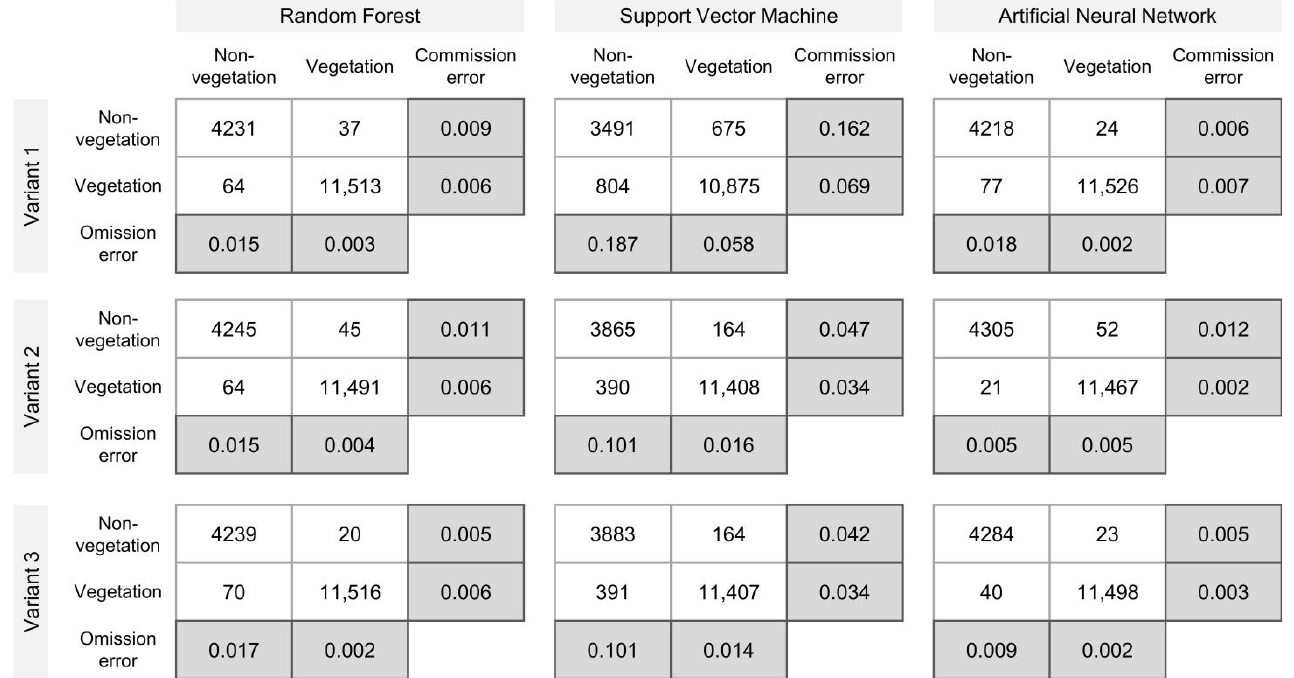
Figure 6. Error matrices from three evaluated machine learning algorithms and three input data variants.